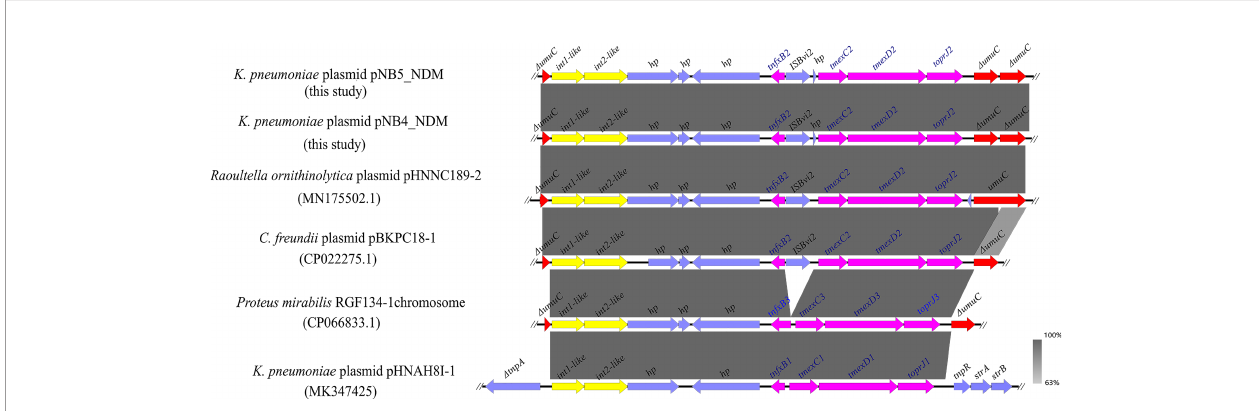
FIGURE 2 | Comparison analysis of the genetic context of tmexCD2 - toprJ2 with that of closely related sequences. The pink arrows indicate tnfxB2-tmexCD2- toprJ2 and tnfxB1-tmexCD1-toprJ1-like gene clusters. The yellow arrows indicate the int-like genes. The gene umuC is indicated by red arrows. IS Bvi2 and hp are indicated by blue arrows. The symbol D indicates that the gene is truncated.